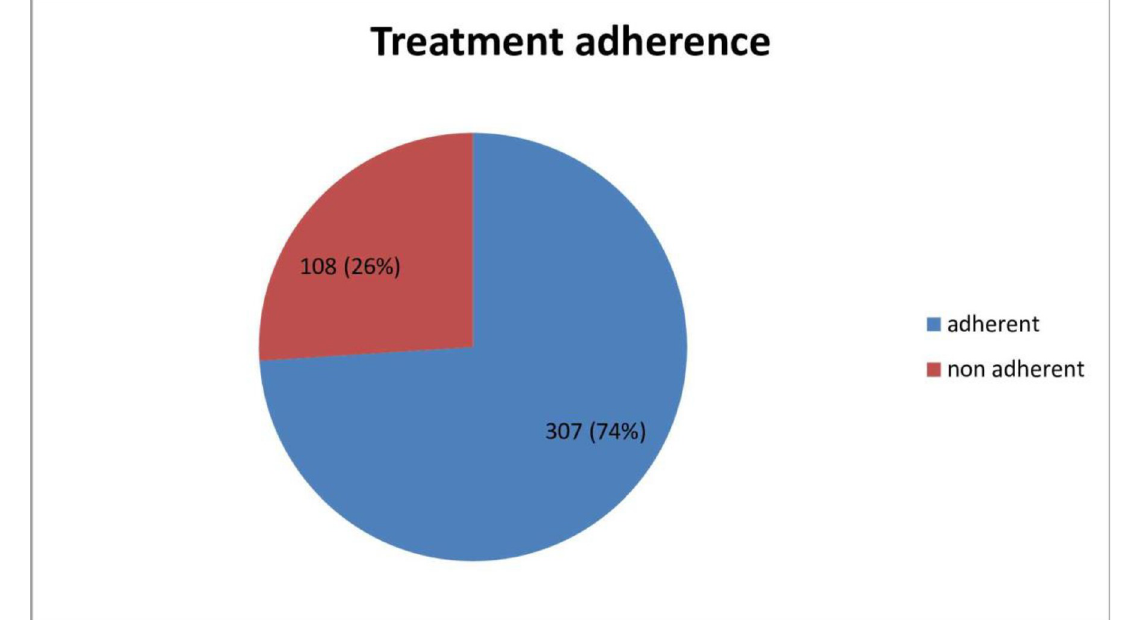
Fig 2. Magnitude of treatment non adherence among study